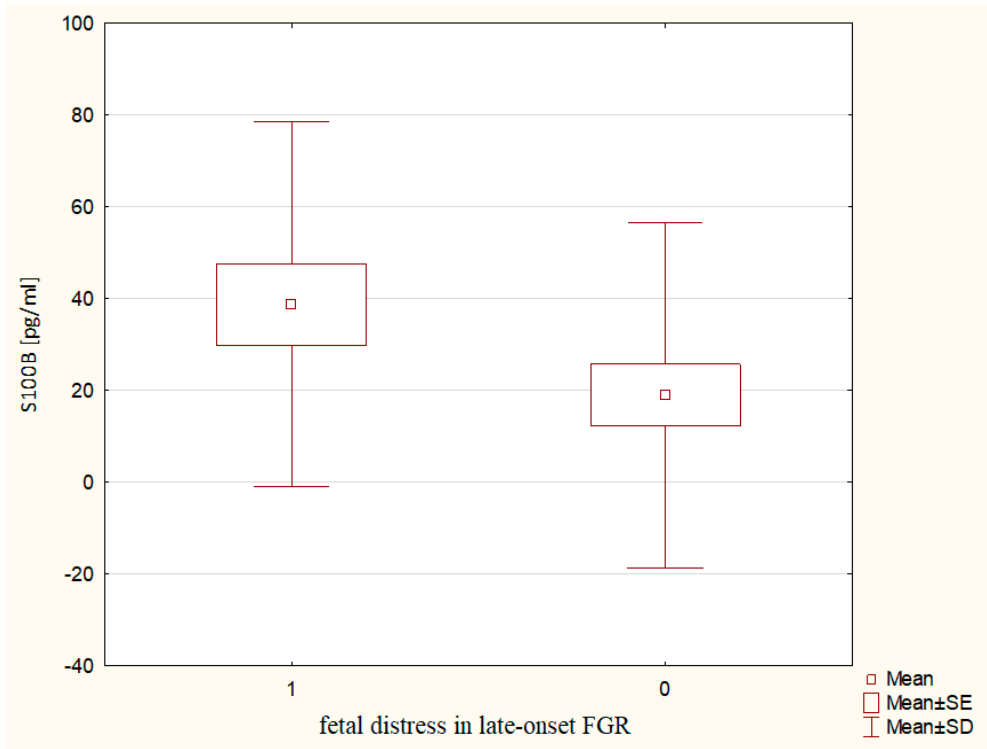
Figure 4. The maternal serum S100B concentrations in relation to fetal distress in the late-onset FGR. A significant relationship between serum zo-1 concentrations and moderate fetal ac- idosis was found in pregnancies complicated by late-onset FGR. The mothers whose new- borns developed moderate acidosis had significantly higher serum zo-1 levels (5.67 ± 6.87 vs. 2.21 ± 5.18 RU/mL, p ~ 0.0471) as compared to the late-onset FGR pregnancies without moderate acidosis after delivery (Figure 5). In addition, the serum zo-1 concentrations may serve as a useful biomarker in the prediction of moderate acidosis in late-onset FGR neonates (cut-off value for zo-1: 0.157 RU/mL, sensitivity 0.86, specificity 0.78, PPV 0.40, NPV 0.96, AUC 0.747, p ~ 0.0380).